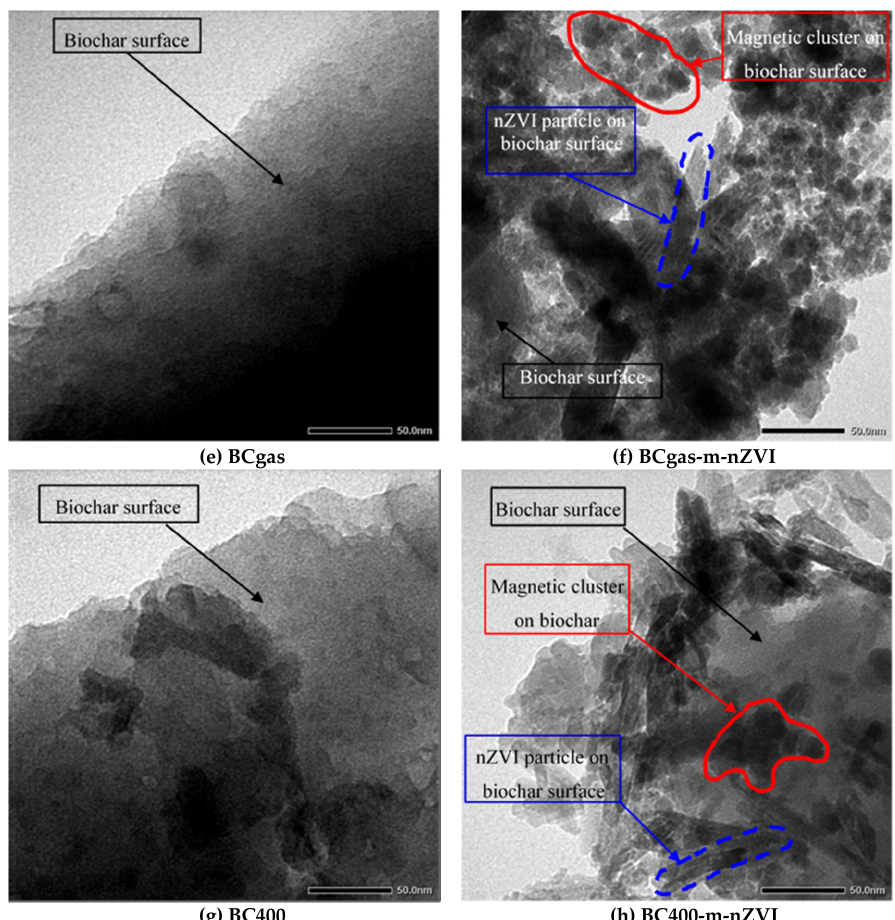
Figure 3. Transmission electron micrographs (JEM-1400 TEM, JOEL USA Inc., Peabody, MA, USA) at × 100,000 magnification (with the scale of 50.0 nm) of the materials of ( a ) nano zero valent iron (nZVI);